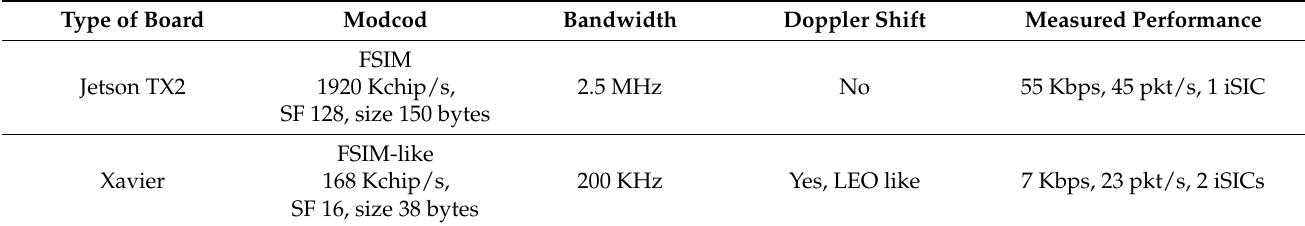
Table 3. Non-optimized demodulation performance for GPU device usable on small LEO satellite.